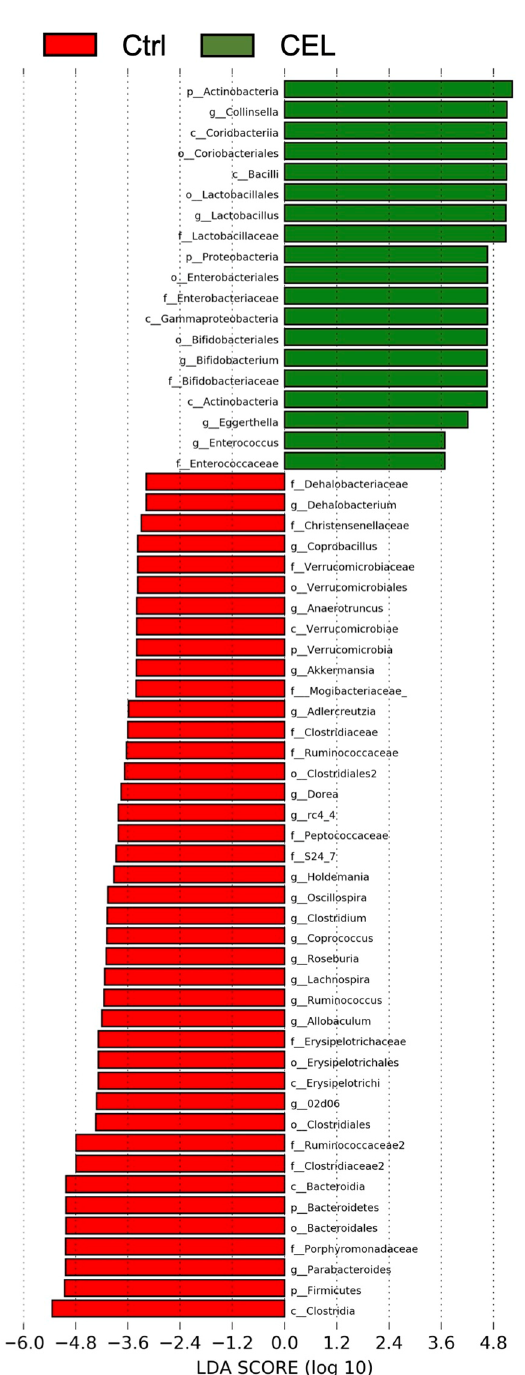
Figure 2. Different taxa between the Ctrl and CEL groups. LEfSe analysis was performed to compare the different taxa between the Ctrl and CEL groups. The two-tailed nonparametric Kruskal–Wallis test was used to evaluate the significance of differences between taxa at p < 0.05.